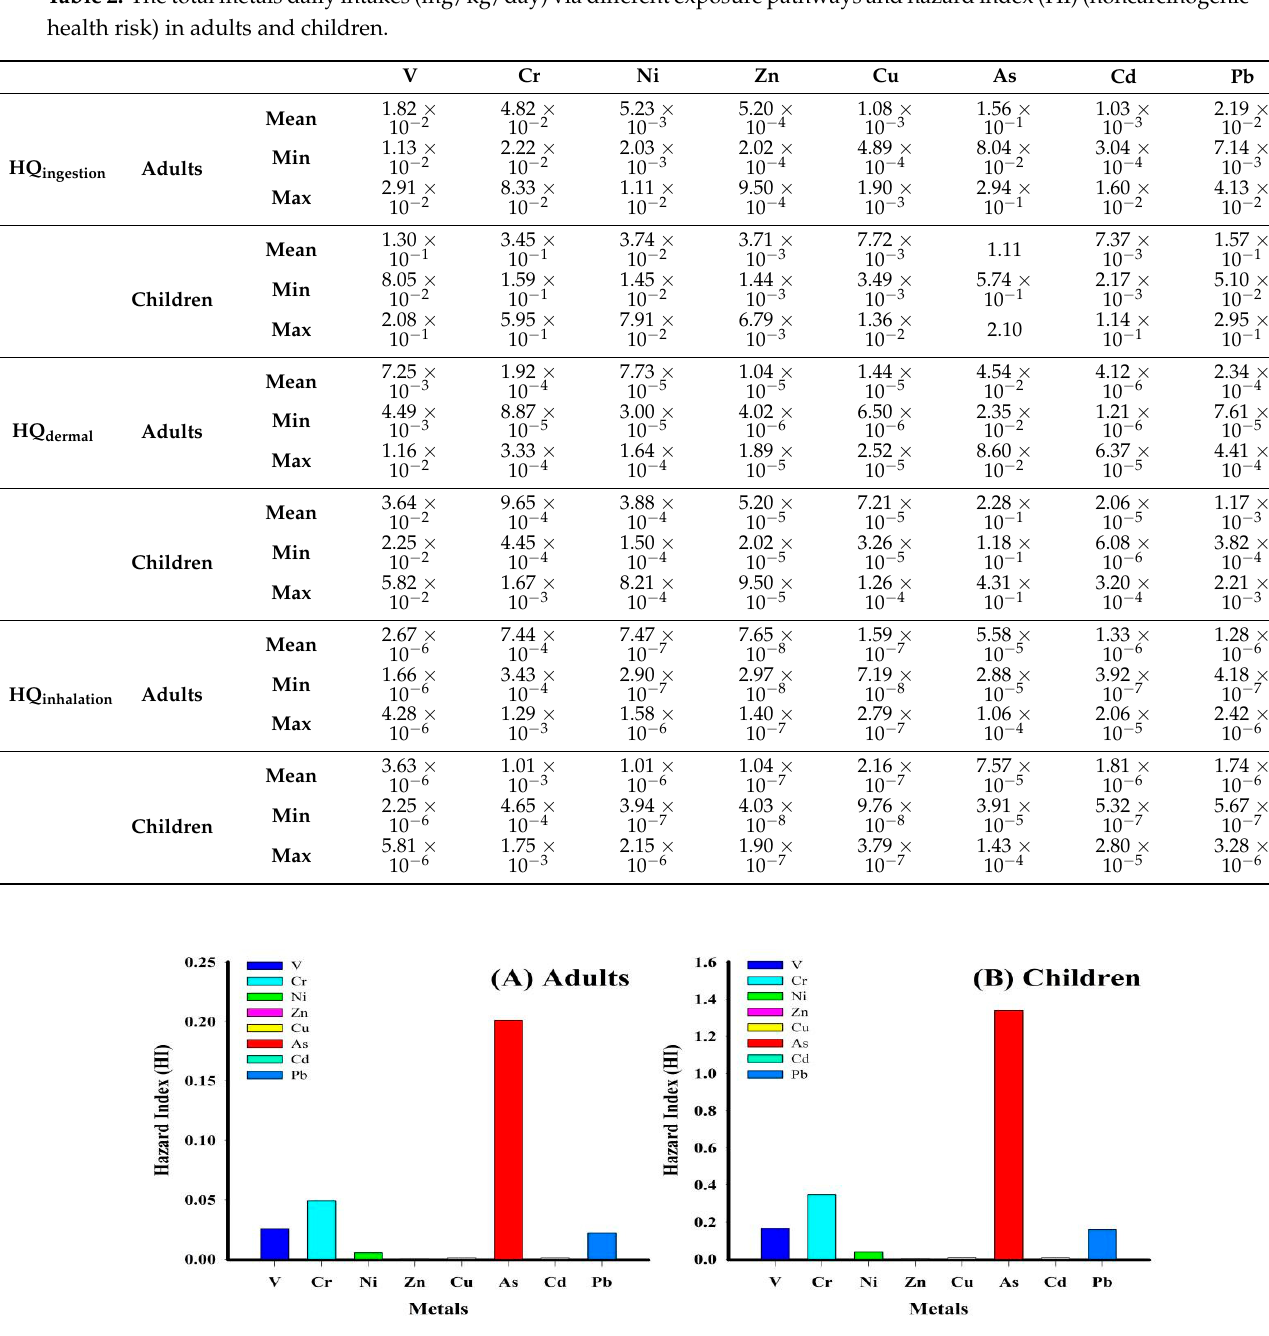
Table 2. The total metals daily intakes (mg/kg/day) via different exposure pathways and hazard index (HI) (noncarcino- genic health risk) in adults and children.